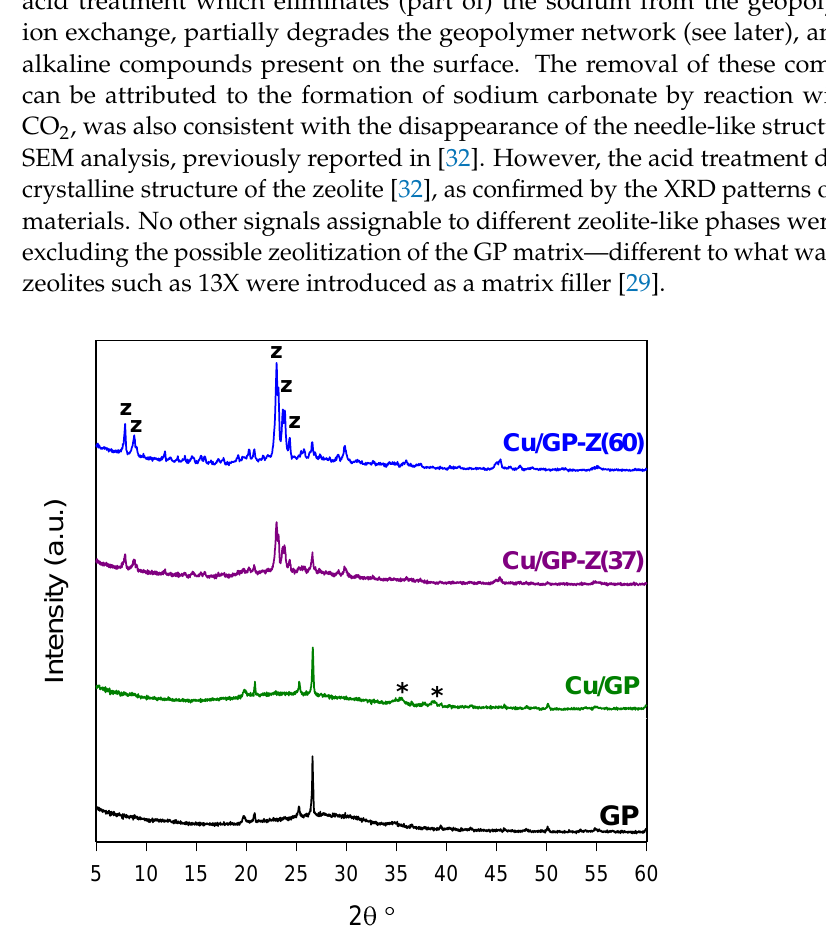
Figure 2. XRD patterns of as synthesized GP and Cu/GP–Z(x) monolith catalysts. Legend: z = ZSM5; * = CuO.